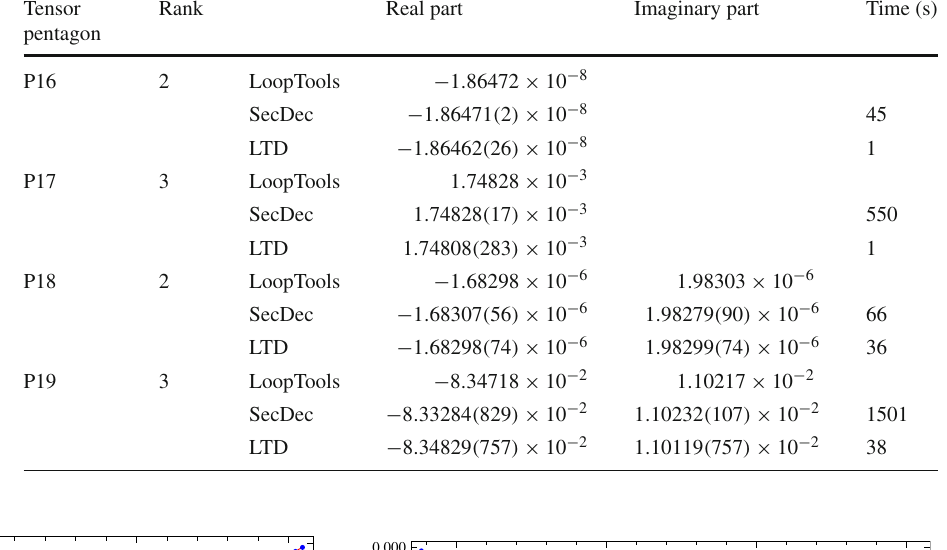
involving numerators of rank two and rank three